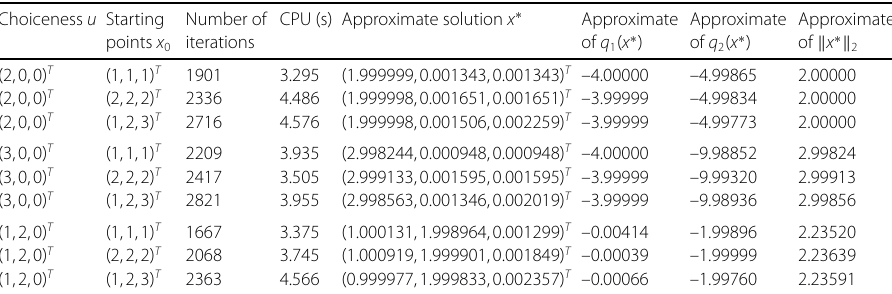
Table 6 Results for Example 5.5 using Algorithm in Corollary